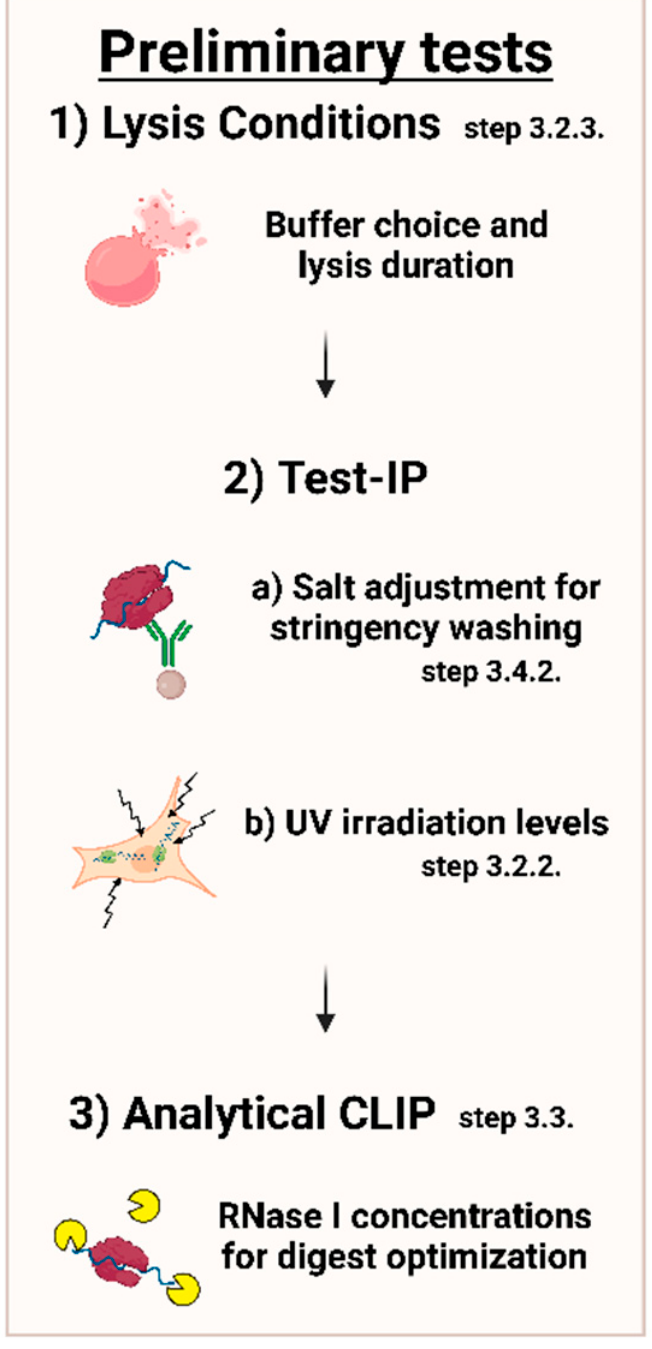
Figure 3. Overview of important conditions to adjust in preliminary tests. Conditions should be adjusted in order of lysis conditions with respect to the buffer system and incubation length, stringency of washing with various salt concentrations, along with UV irradiation, followed by RNase I concentrations.